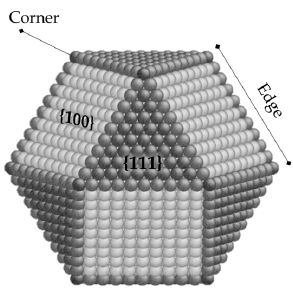
Figure 6. Schematic representation of typical active sites in an cuboctahedral metal nanoparticle.